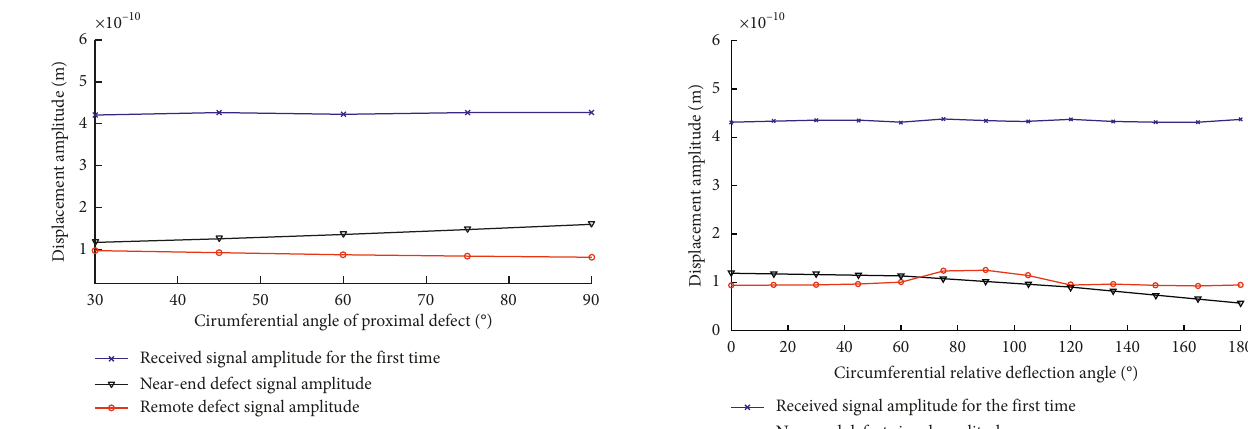
Figure 14: Deformation amplitude curves of different size defects.